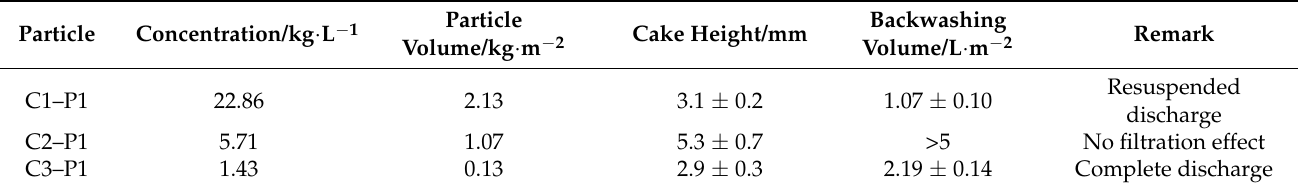
Table 3. Cake height and backwashing volume at a cellulose quantity of 1 kg · m − 2 (option 2) with particle system P1 at a backwashing pressure of 0.5